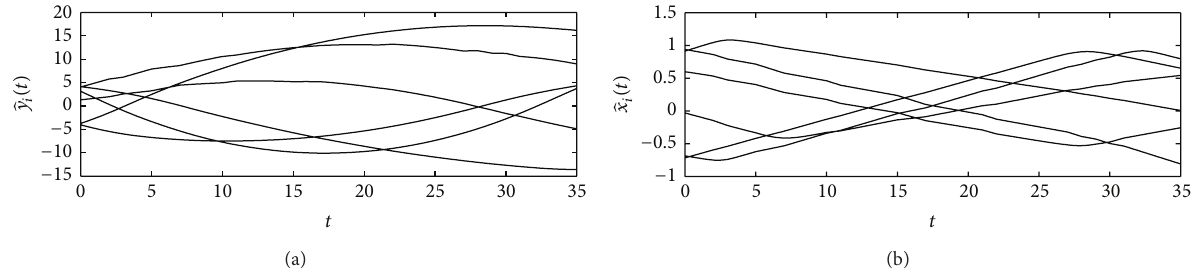
Figure 3: The evolution curves of the error states of supply networks without control.